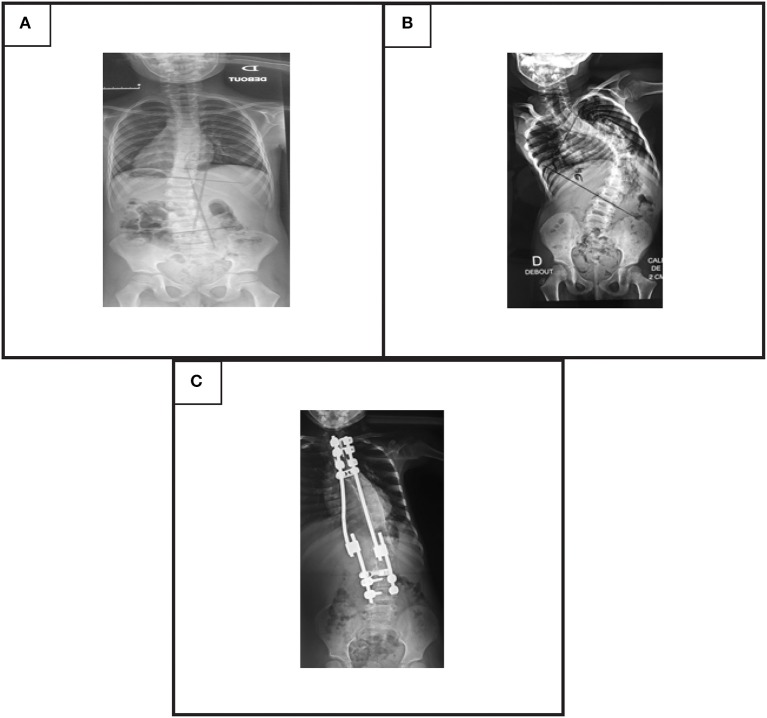
Postero-anterior view of X-ray showing scoliosis: (A) mild double major scoliosis stable without treatment in patient V4 of family 2, (B) severe thoracic scoliosis with a 94° Cobb's angle in patient IV3 of family 5, (C) 2 years after surgical correction with dual traditional growing rods in patient IV3 of family 5.